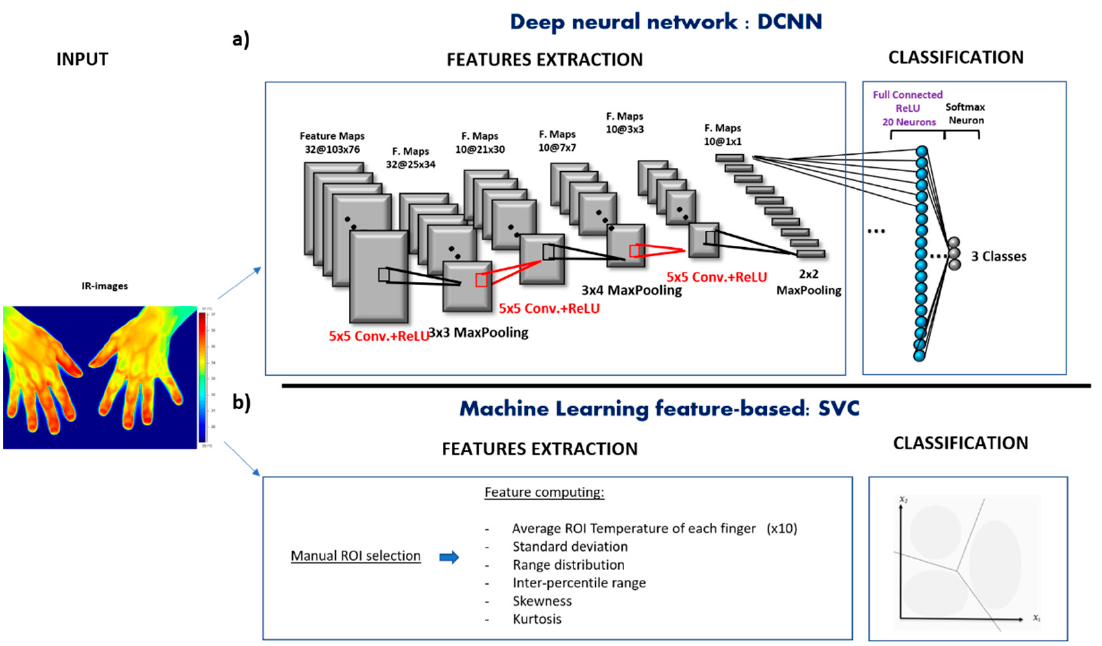
Figure 1. ( a ) Deep Convolutional Neural Network (DCNN) pipeline, which includes the structure of the convolution building block implemented. ( b ) Machine learning feature-based algorithm pipeline, which include the features extracted for the baseline analysis .